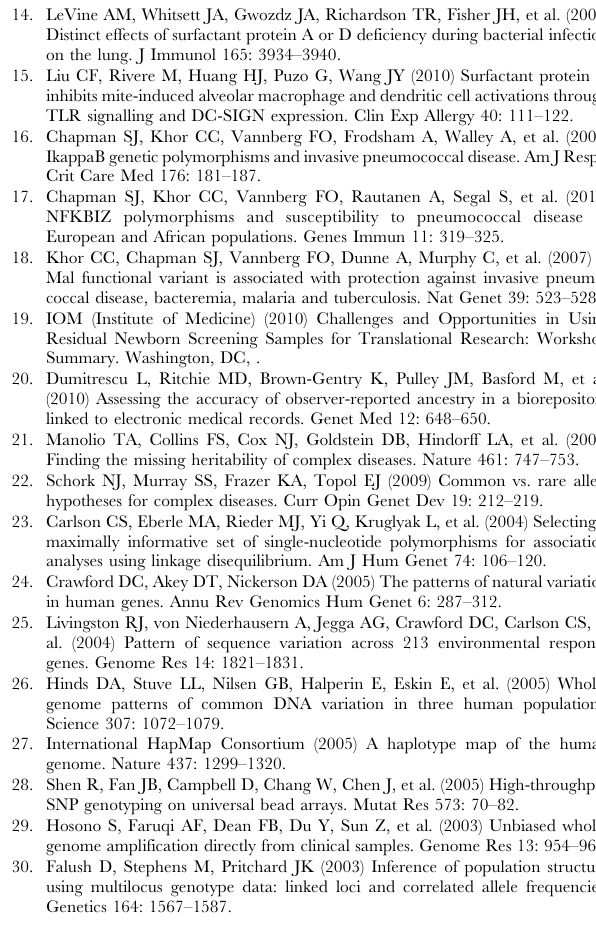
Table S2 tagSNPs in candidate genes found associated with IPD. For European-Americans (182 Cases and 361 Controls), and African-Americans (53 Cases and 113 Controls). Allelic (2 6 2) and genotypic (2 6 3) models are used to calculate allelic, heterozygote and homozygote OR, 95% confidence intervals (CI) and minor allele frequency (MAF). Variants are ordered by decreasing significance of the allelic p-value. Table S3 tagSNPs in candidate genes found associated with bacteremia. For European-Americans (120 Cases and 361 Controls) with 213 SNPs passing QC (HWE . 0.0001, MAF . 0.01, Genotyping efficiency . 90%) and African-Americans (39 Cases and 113 Controls) with 281 SNPs passing QC. Allelic (2 6 2) and genotypic (2 6 3) models are used to calculate allelic, heterozygote and homozygote OR, 95% confidence intervals (CI) and minor allele frequency (MAF). Variants are ordered by decreasing significance of the allelic p-value.